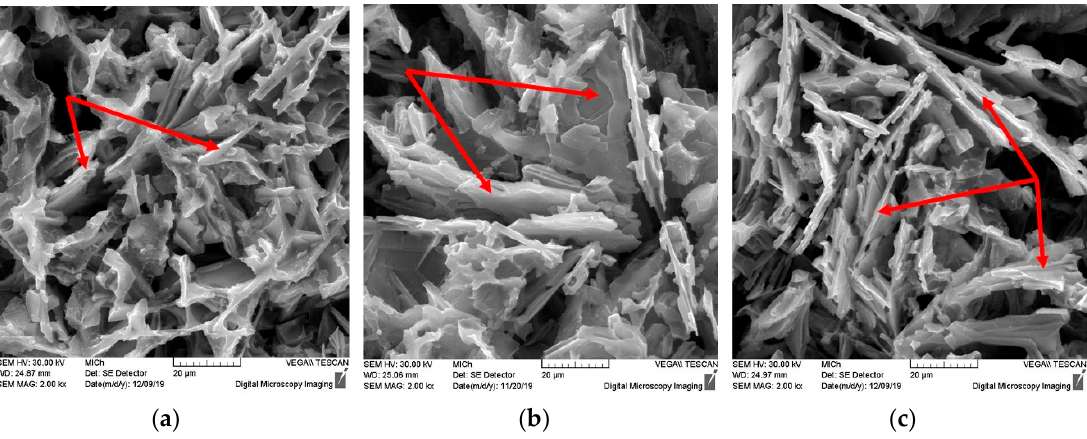
Figure 6. Changes of eutectic Si of AlSi9Cu3 alloy depend on the ratio of returnable material in the batch after artificial aging, SEM; ( a ) 20–80 alloy, ( b ) 50–50 alloy, ( c ) 90–10 alloy.